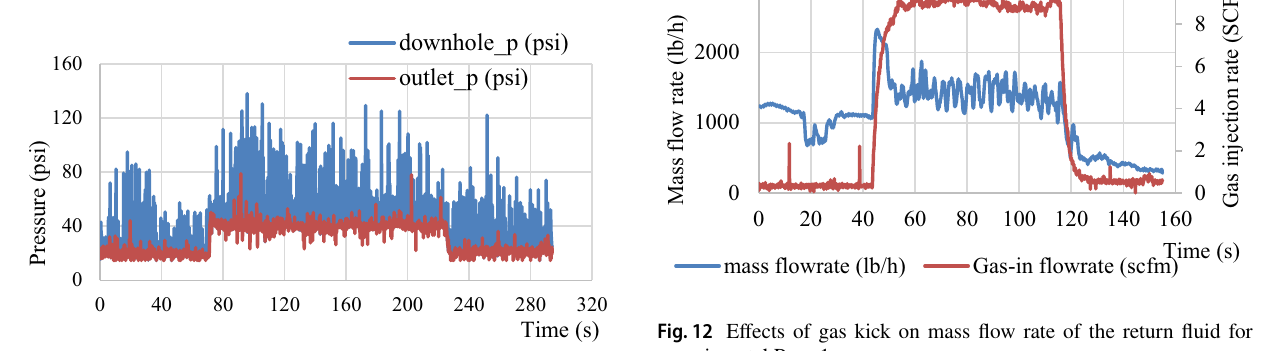
Fig. 9 Effects of gas kick on bottomhole pressure for experimental